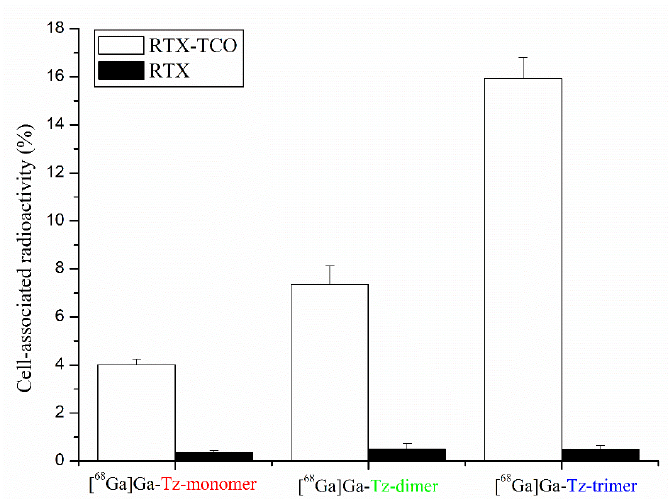
Figure 2. Cell-binding studies of 68 Ga-labelled FSC-based Tz-ligands on CD20-expressing Raji cells pre-treated with anti-CD20 antibody RTX (negative control, black bars) and its TCO modified counterpart (white bars).